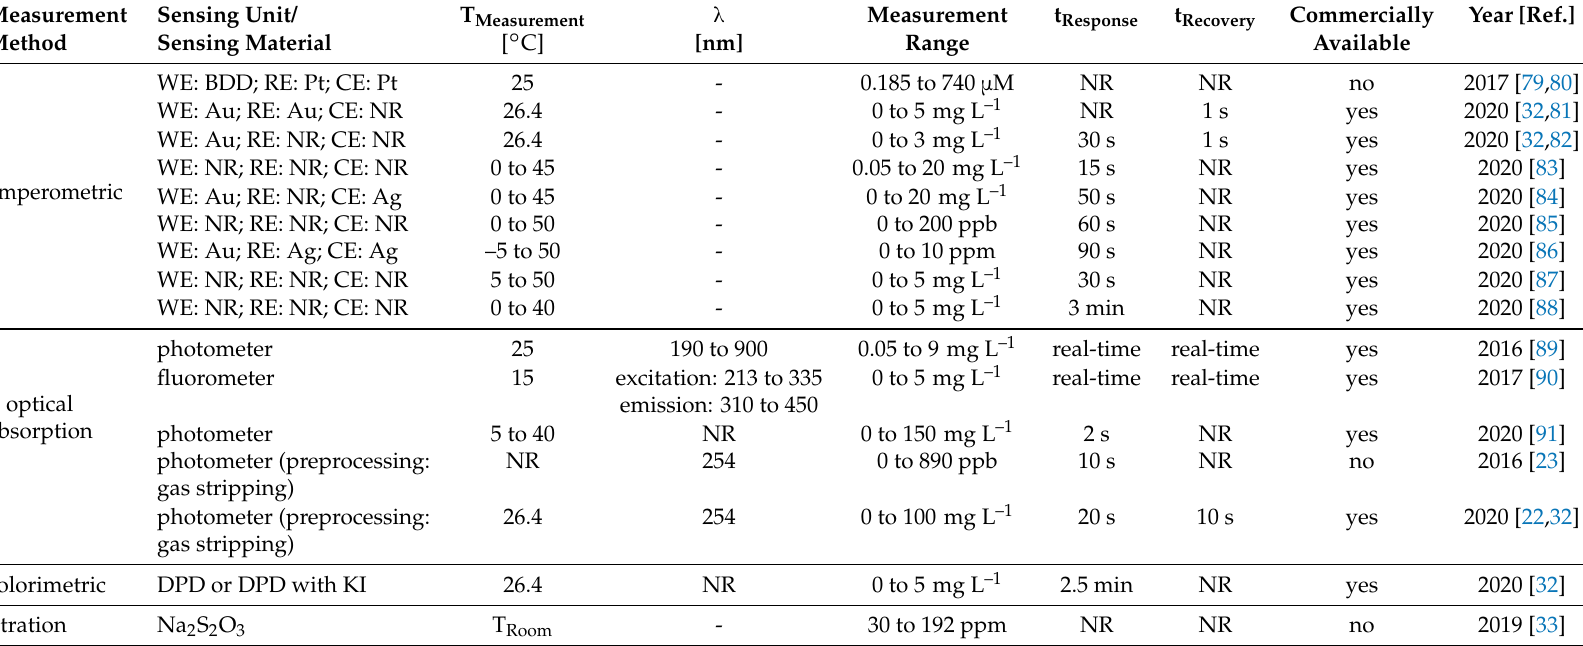
NR: not reported; WE: working electrode; RE: reference electrode; CE: counter electrode; BDD: boron-doped diamond electrode; DPD: N,N-diethyl-p-phenylenediamine; KI: potassium